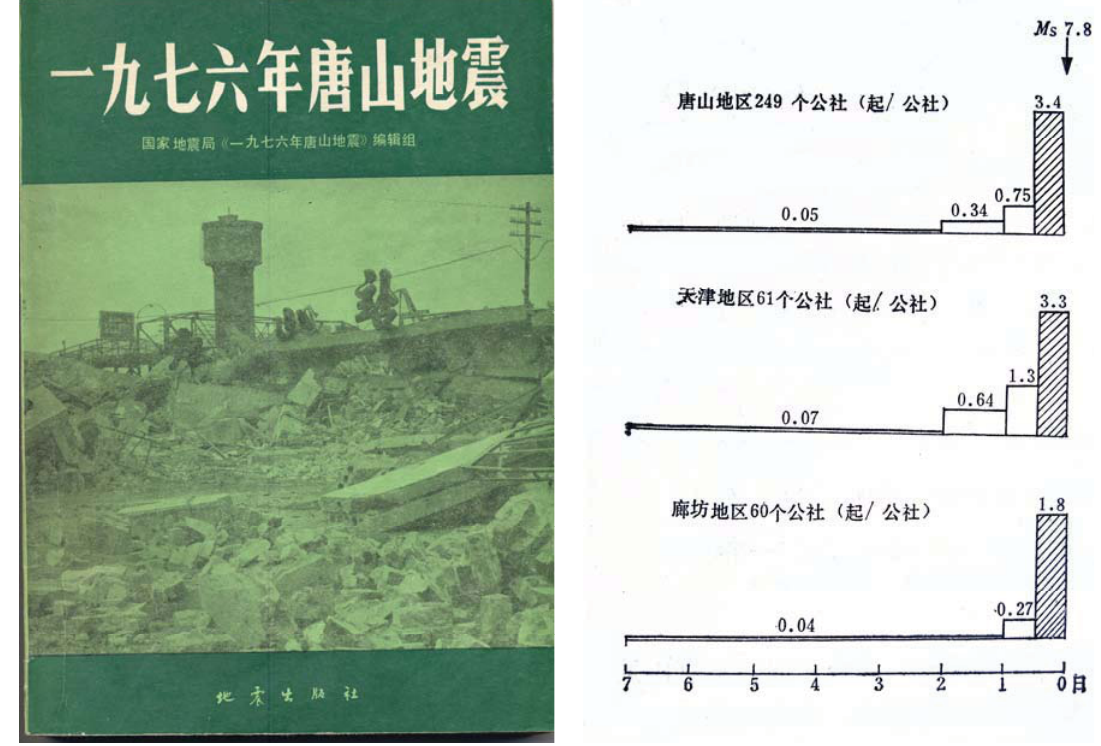
Figure 5. The Chinese report on “The Tangshan Earthquake of 1976” [27] with documentation of the observed unusual animal behaviour. The right graph shows the increase of unusual animal behaviour towards the earthquake event (M = 7.8). The horizontal scale indicates days before the earthquake. The chinese writing on the right picture means: top: District of Tangshan (249 people’s comunes). Center: District